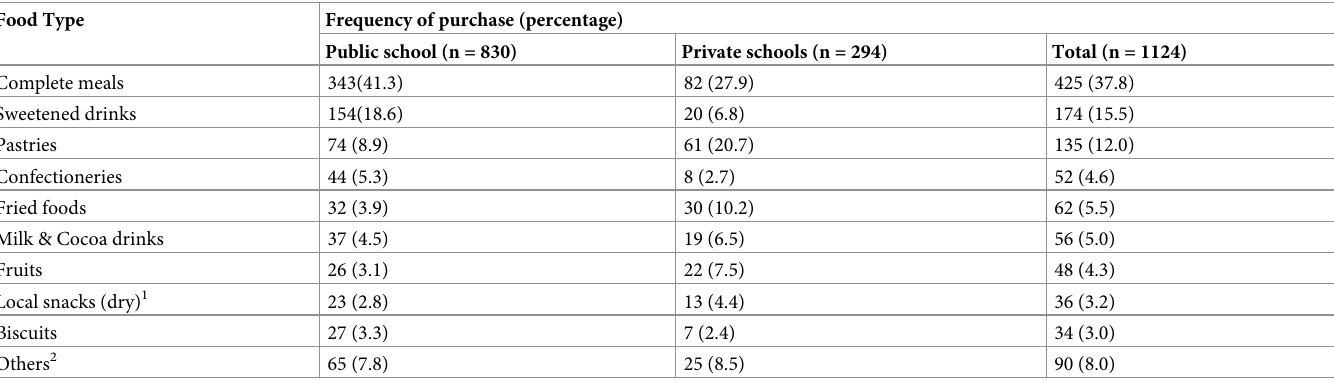
Table 1. Frequency of pupil purchase of foods during mid-morning break period by school